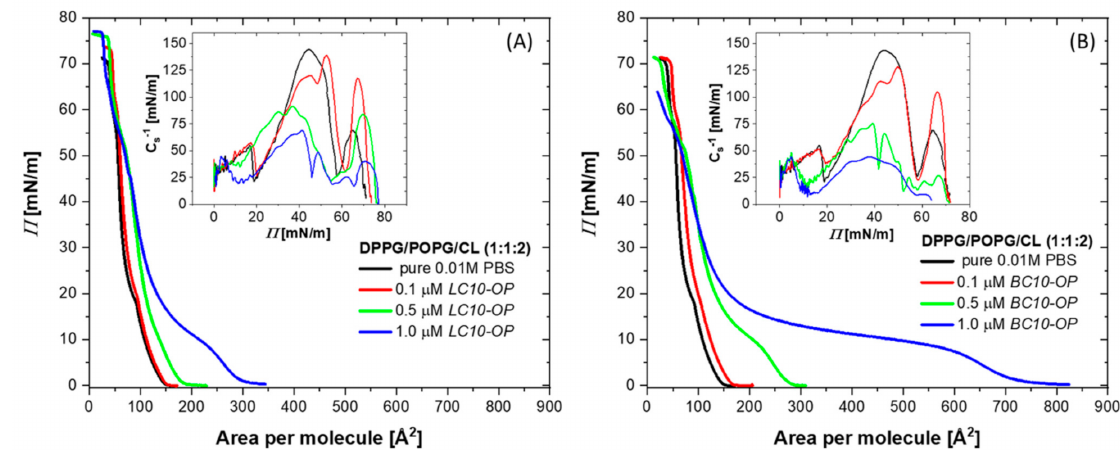
Figure 1. Surface pressure ( Π ) versus area per molecule ( A ) isotherms recorded for 1-palmitoyl-2-oleoyl- sn -glycero-3- phosphoglycerol (POPG), 1,2-dipalmitoyl- sn -glycero-3-phosphoglycerol (DPPG), and 1 (cid:48) ,3 (cid:48) -bis[1,2-dimyristoyl- sn -glycero-3- phospho]-glycerol (CL) monolayers in the absence (black curves) and in the presence of lipopeptides dissolved in a subphase (colored curves). Panel ( A ) demonstrates the results for different concentrations of LC10-OP, while panel ( B ) shows the results obtained for BC10-OP. An aqueous solution of 0.01 M phosphate-buffered saline (PBS) was used as a subphase. The insets show the changes in the compression modulus as a function of surface